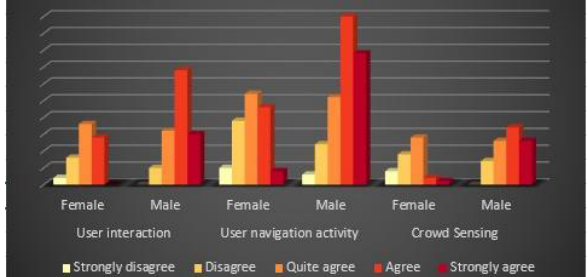
Figure 4. The summary of responses to the app’s usability on interactions, navigation processes, and crowdsensing utility.